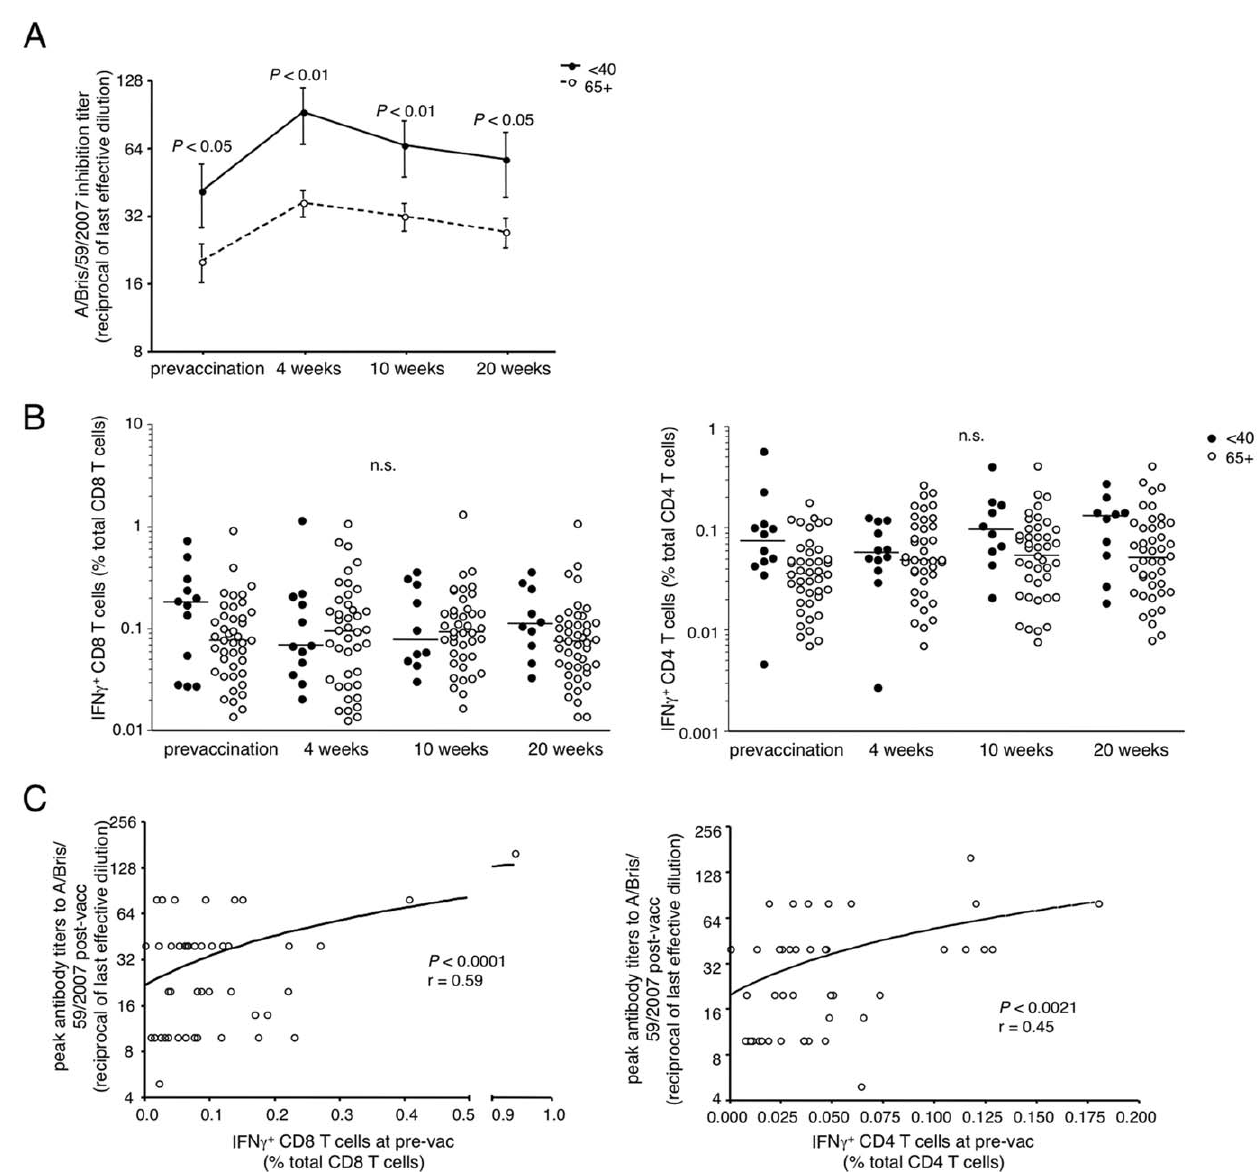
Figure 4. An effective T cell response to whole influenza stimulation prevaccination predicts higher peak antibody titers post- vaccination. Antibody production pre-vaccination and four, ten, and twenty weeks post-vaccination with TIV was measured by hemagglutinin inhibition assay. Titers against A/Brisbane/59/2007, an H1N1 strain contained in the seasonal vaccine, are shown. T cell responses post-vaccination were measured as described in Figure 1 for pre-vaccination samples. (A) Antibody responses in serum from young ( line) donors against A/Brisbane/59/2007 (H1N1) before and after vaccination with TIV. (B) CD8 ( left ) and CD4 ( right ) T cell responses to PR8 before and after vaccination as measured by IFN c cytokine production. (C) Correlation between IFN c + CD8 ( left ) and CD4 ( right ) T cells present at pre-vaccination and peak antibody titers post-vaccination with TIV in older donors.